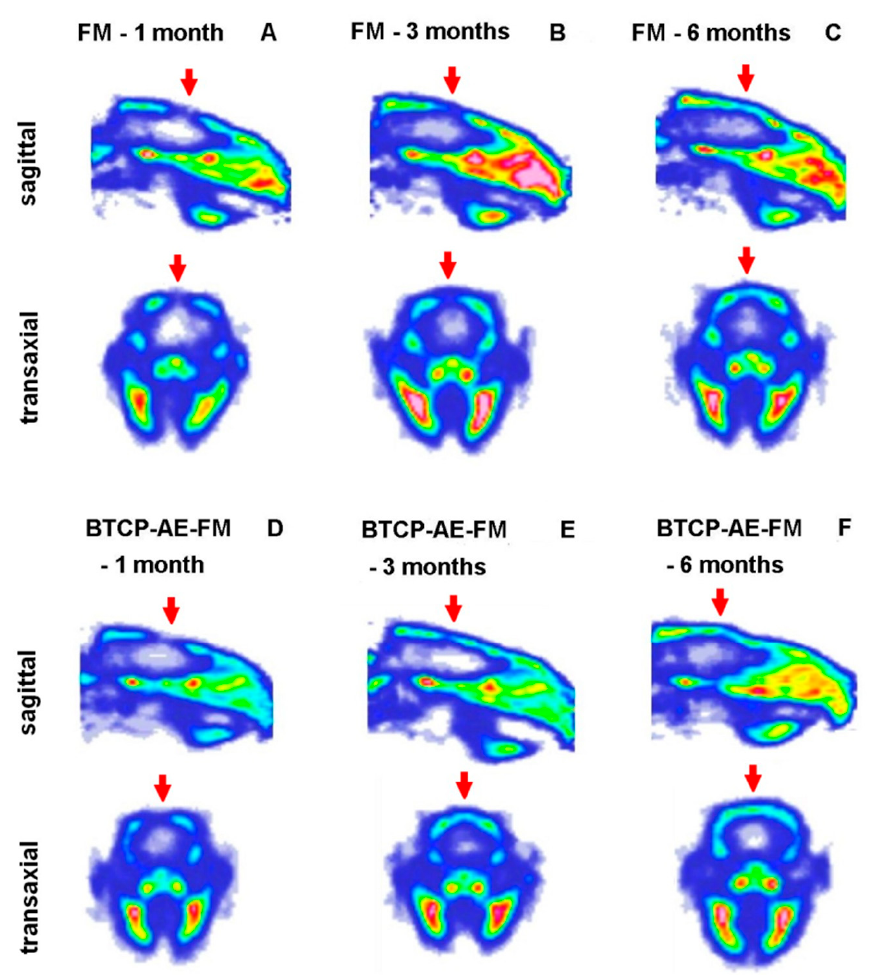
Figure 12. In vivo PET imaging of rat calvaria using [ 18 F]fluoride. Representative decay-corrected PET images were obtained 1, 3, and 6 months after surgery and 50 min following intravenous injection of the radiopharmaceutical. ( A – C ): sagittal and transaxial PET images of rats implanted with the FM; ( D – F ): sagittal and transaxial PET images of rats implanted with the BTCP-AE-FM. Red arrows: area of the cranial trepanation